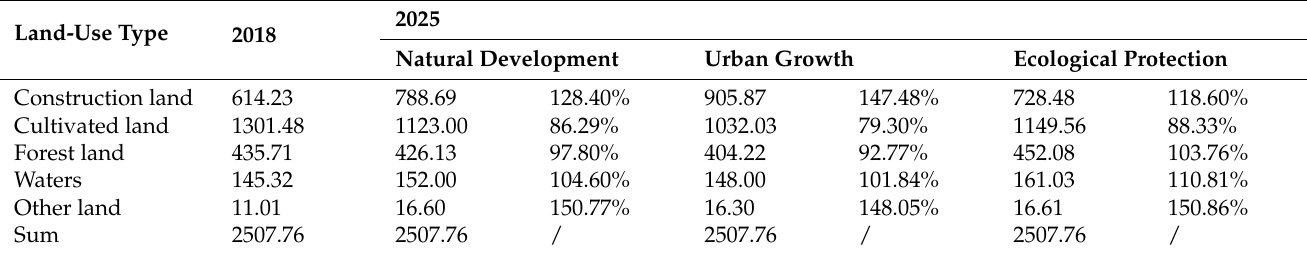
Table 4. Comparison of landscape pattern indexes in the study area between 2018 and 2025.